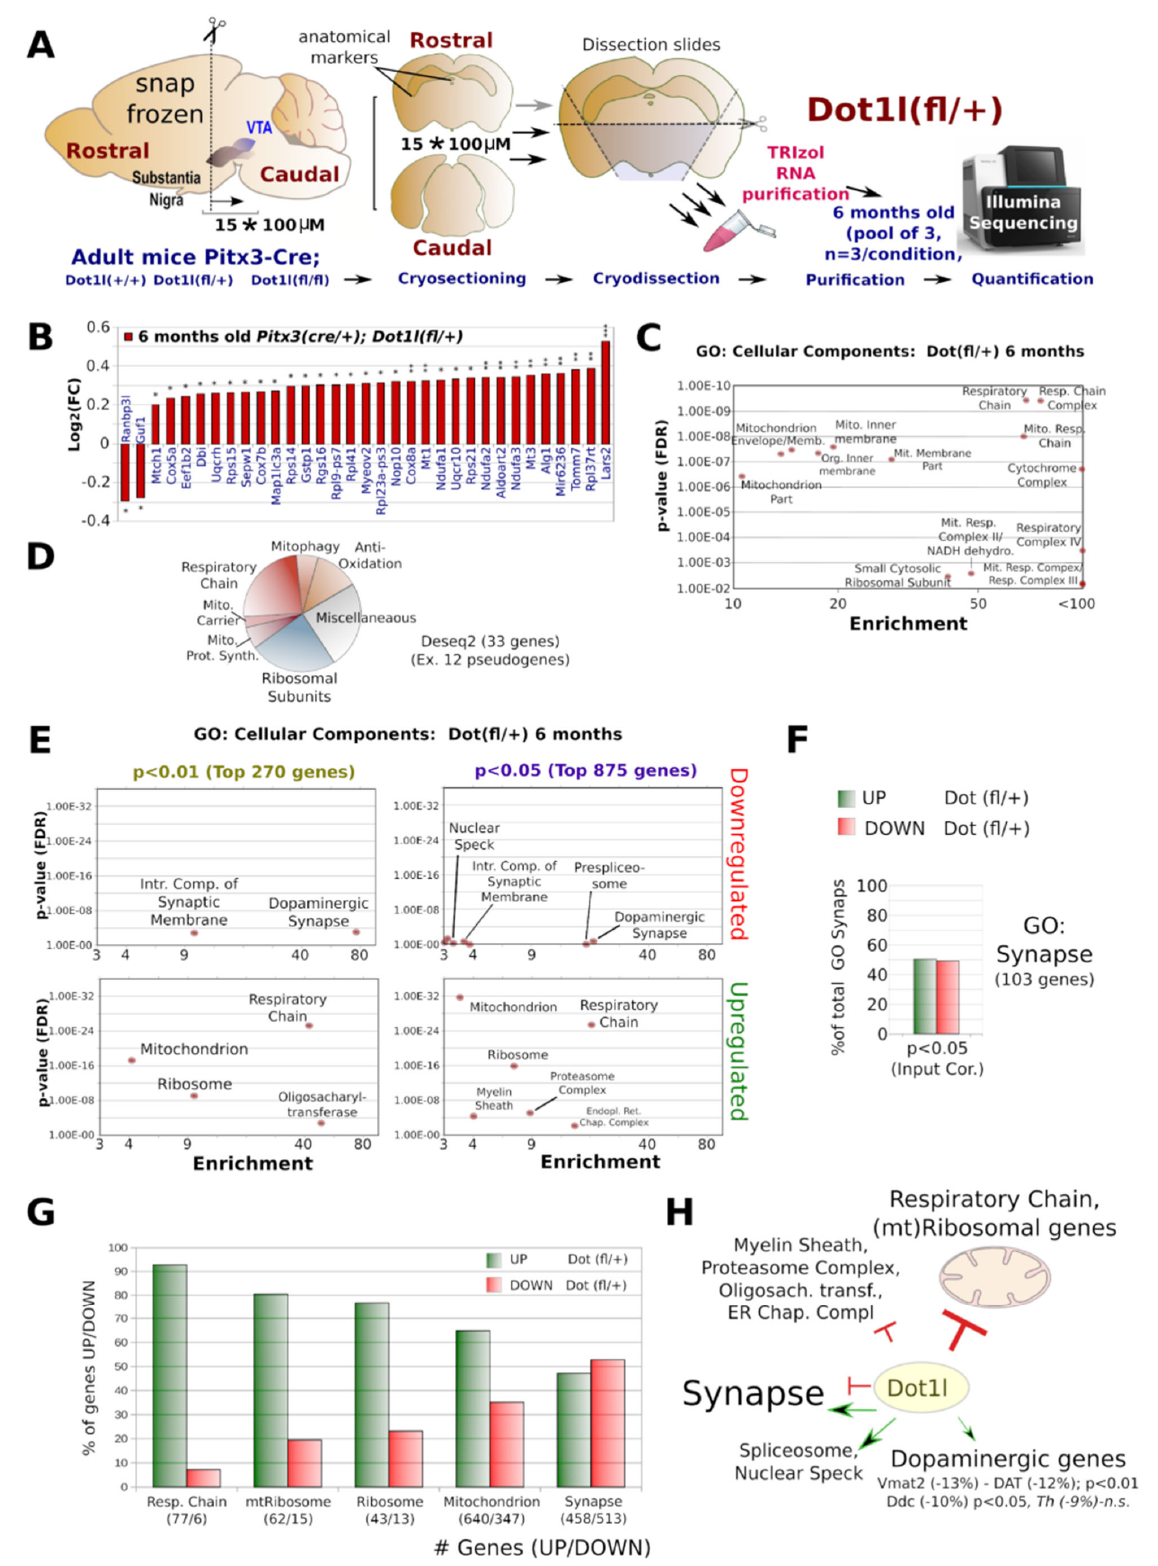
Figure 5. Transcriptome profiling of 6-month-old Pitx3(Cre / +) ; Dot1l(fl / +) mice. ( A ) Schematic overview of the dissection and transcriptomics approach. Snap frozen 6-month-old mice brains were sliced in a cryostat until rostral anatomical markers of the midbrain were reached. Exactly 15 slices, 100 µ m thick, were sliced and the ventral midbrain area was further dissected by removing the